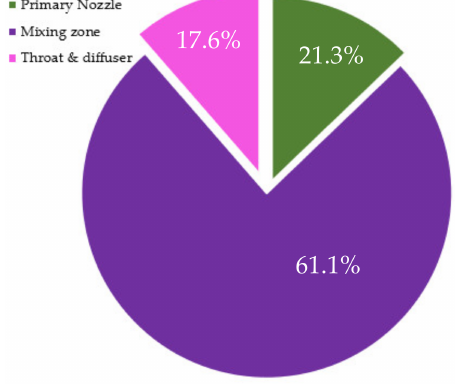
Figure 11. Exergy destruction within